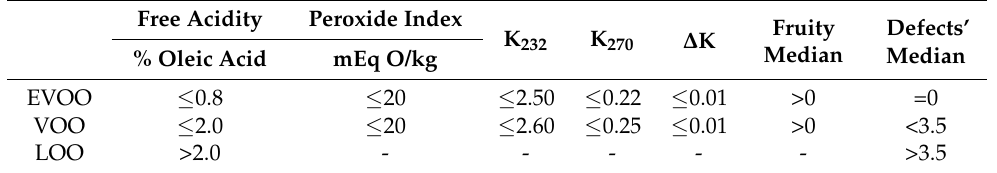
Table 2. Quality standards of virgin olive oil as requested by current legislation (EU Reg. (EEC) 2568/91 as amended, that also establish the official methods for their determination